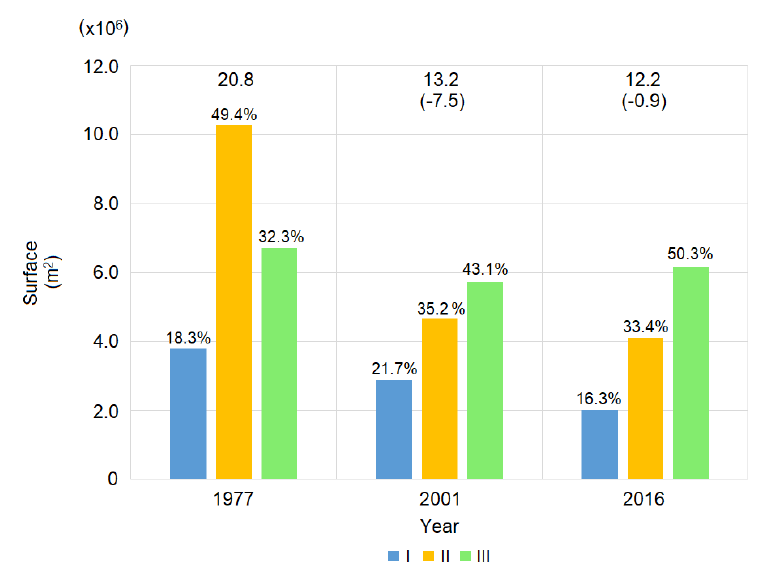
Figure 3. Yearly surface values of each dune typology, i.e., “Embryo and mobile dunes” (Type I), “Grass - fixed dunes” (Type II) and “Stabilized dunes” (Type III). Value on top represents the surface of all dune typologies and in brackets the surface that was lost with respect to the previous year is reported.